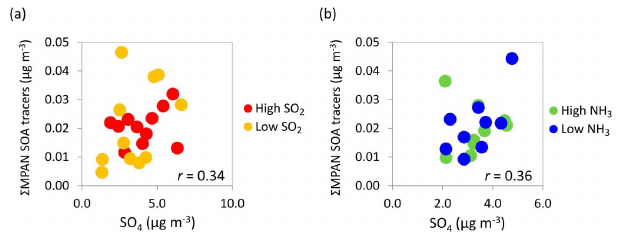
Fig. 13. Correlations between the sum of MAE-derived SOA tracers and the particle sulfate loadings: (a) SO 2 conditional samples; (b) NH 3 conditional samples. Positive correlations were observed for both SO 2 and NH 3 conditional samples, suggesting surface area could be a limiting factor that modulates isoprene high-NO x SOA formation.